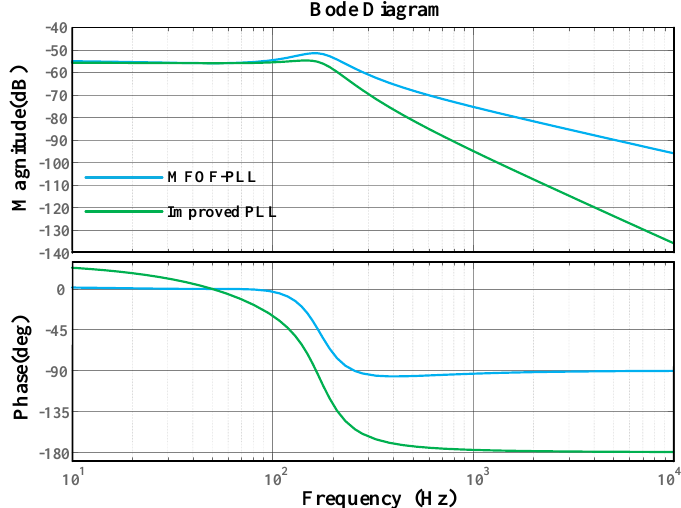
Energies 2022 , 15 , x FOR PEER REVIEW Figure 13. Bode plot of the transfer function from s PCCdq u to r gdq i . Figure 13. Bode plot of the transfer function from u s PCCdq to i r gdq .